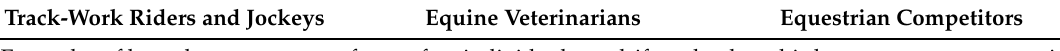
Table 2. Examples from track-work riders and jockeys, equine veterinarians and equestrian competitors that illustrate the drifting awareness that increase the risk of injuries. Track-Work Riders and Jockeys Equine Veterinarians Equestrian